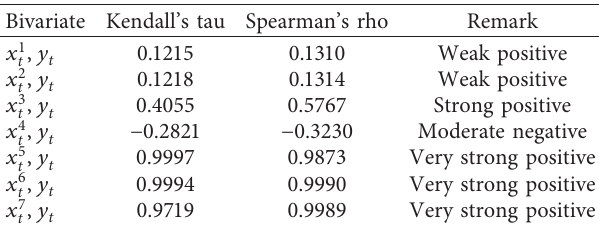
Figure 6: Time series of rainfall intensity, reservoir level, reservoir fluctuation, landslide displacement, and velocity obtained from the multisensor monitoring system spanning the period of October 2006 to June 2015. Table 3: Correlation coefficients between input variables and landslide